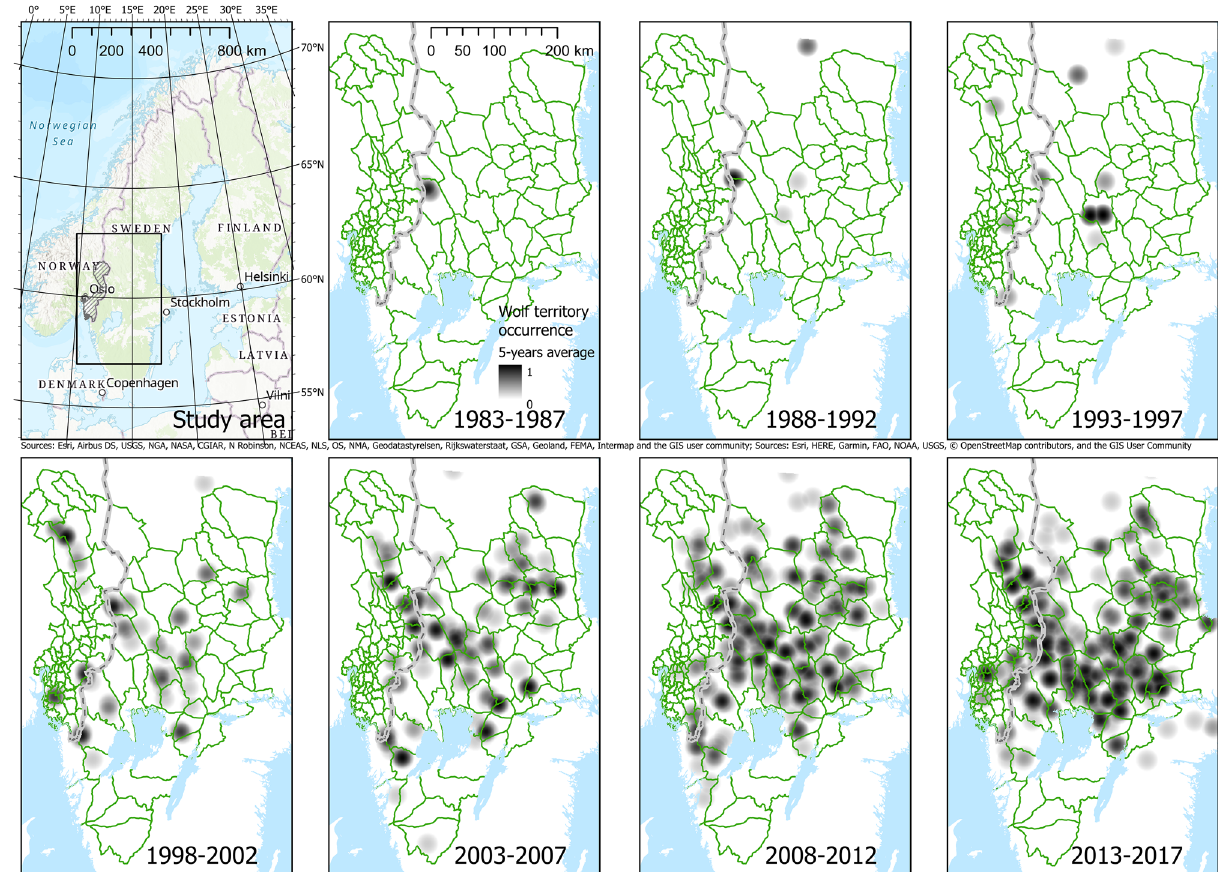
Figure 2. Long-term wolf index in the study area in Norway and Sweden during the period 1983–2017 (the study period in this study was 1995–2017), calculated as 5-year average annual wolf territory density by using an 18 km buffer from the annual wolf territory centre and a parabolic-shaped decaying probability of use of the area from the centre (1) to 18 km (0). The hatched area represents the Norwegian wolf reproduction zone and the green outlines the moose management units. Maps created with ArcGIS Pro 2.4.2 (Esri Inc), World Topographic Map loaded from https ://cdn.arcgi s.com/shari ng/rest/conte nt/items /7dc6c ea0b1 764a1 f9af2 e679f 642f0 f5/resou rces/style